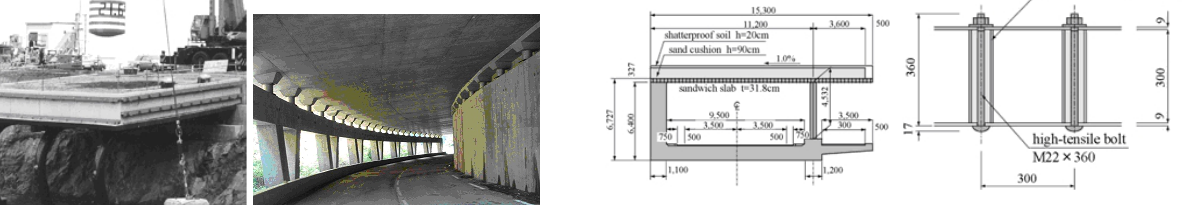
Fig. 12. Full-scale steel-concrete composite rock shed subjected to a falling weight (left; Maegawa et al., 2003), gallery with PSD dissipation system in Val d’Arly, France (right; taken from Masuya, 2007).